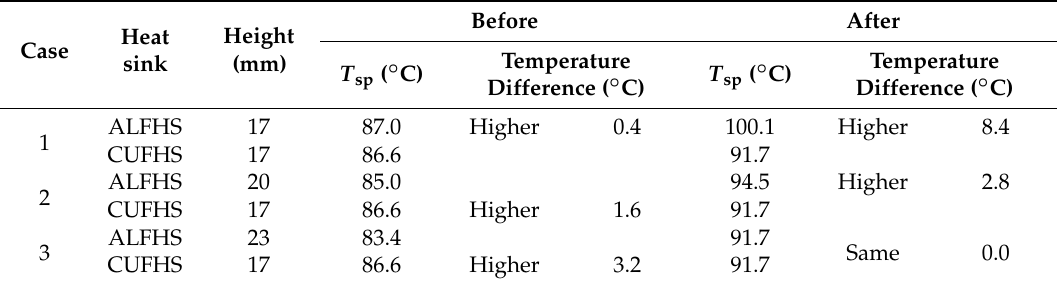
Table 1. Comparison for heat sinks height